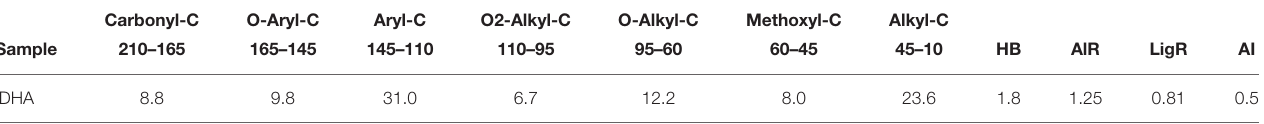
TABLE 3 | Relative contribution (%) of main C structures over chemical shift regions (ppm) calculated from 13 C CPMAS NMR of Idaho HA sample and structural indices derived from spectral areas. Carbonyl-C